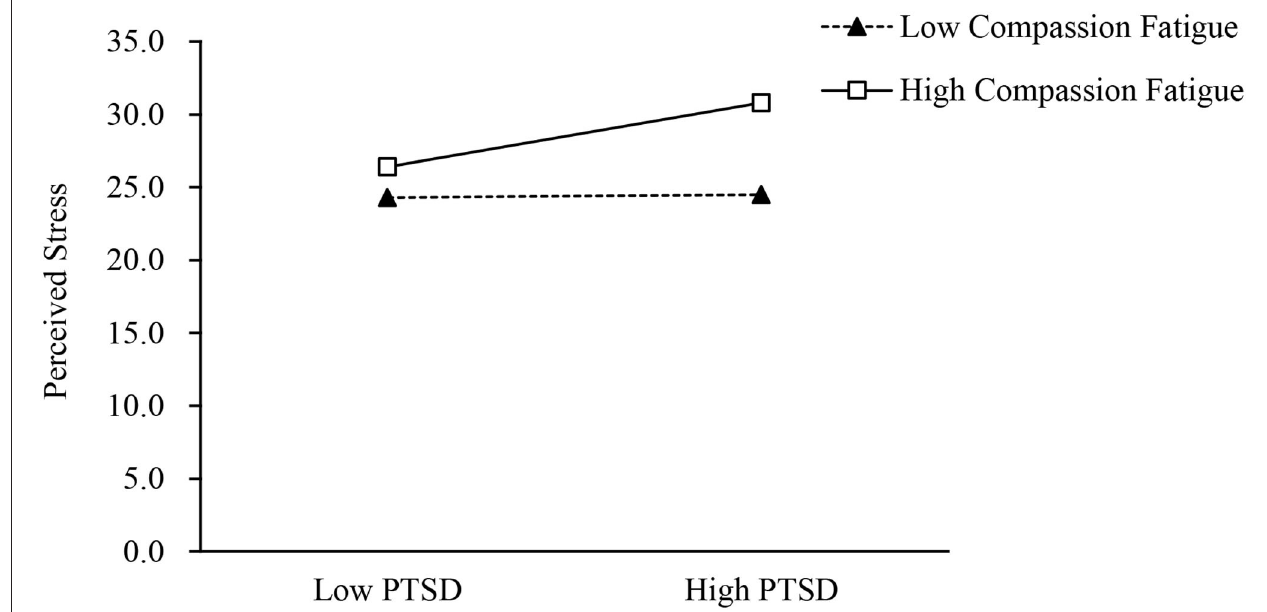
FIGURE 2 | Compassion fatigue moderates the effect of the perceived stress on PTSD.